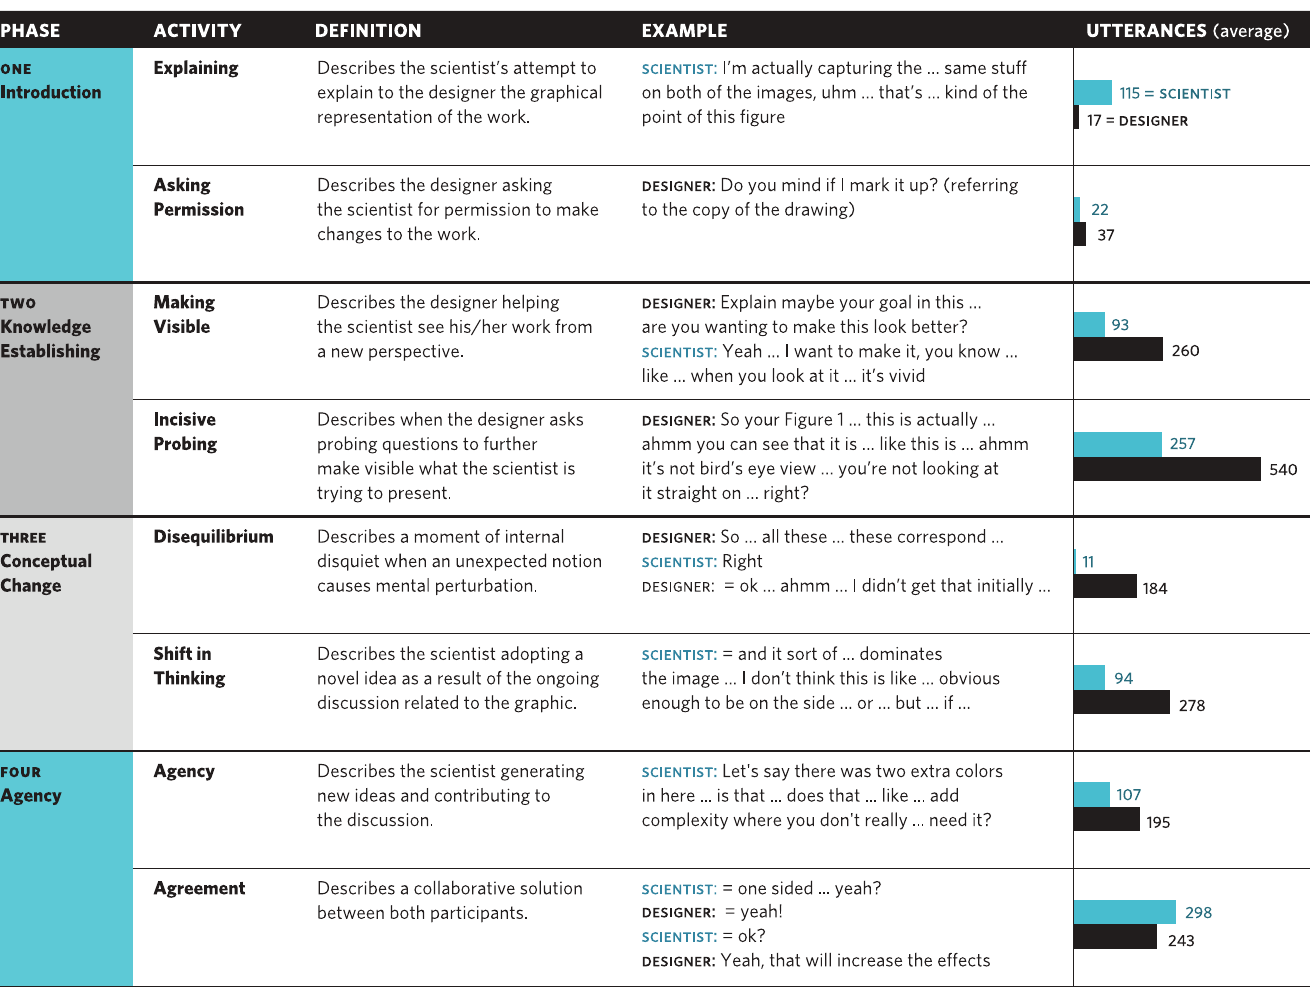
Fig 2. Cognitive interaction coding. Analysis of twelve Design Help Desk sessions identifies specific phases in the interactions between the designer and scientist. Two main activities occur during each phase. The last column shows the average number of utterances during each of these phases. Blue denotes utterances from the scientist, while black is used for the designer. The first and last phases are dominated by the scientist. The second and third phases have more utterances from the designer. Phases vary in length; Disequilibrium is relatively short, while the longest phase is Knowledge Establishing.